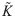
Quantifying protein aggregation in Drosophila Clone 8 cells co-transfected with GCN4-Ci (a predominantly-aggregated protein) and eGFP (a predominantly-soluble protein) in various ratios.
Panel A: Sample images from the five constructs tested. Panel B: Western blot showing the results of subcellular fractionation of the five constructs. Panel C: Quantification of the western blot in panel B using ImageJ. Panel D: K˜ values for the five constructs tested. The number of cells analyzed in constructs 1, 2, 3, 4 and 5 is 17, 15, 16, 27 and 20 cells, respectively. Error bars represent the standard error of the mean (SEM).